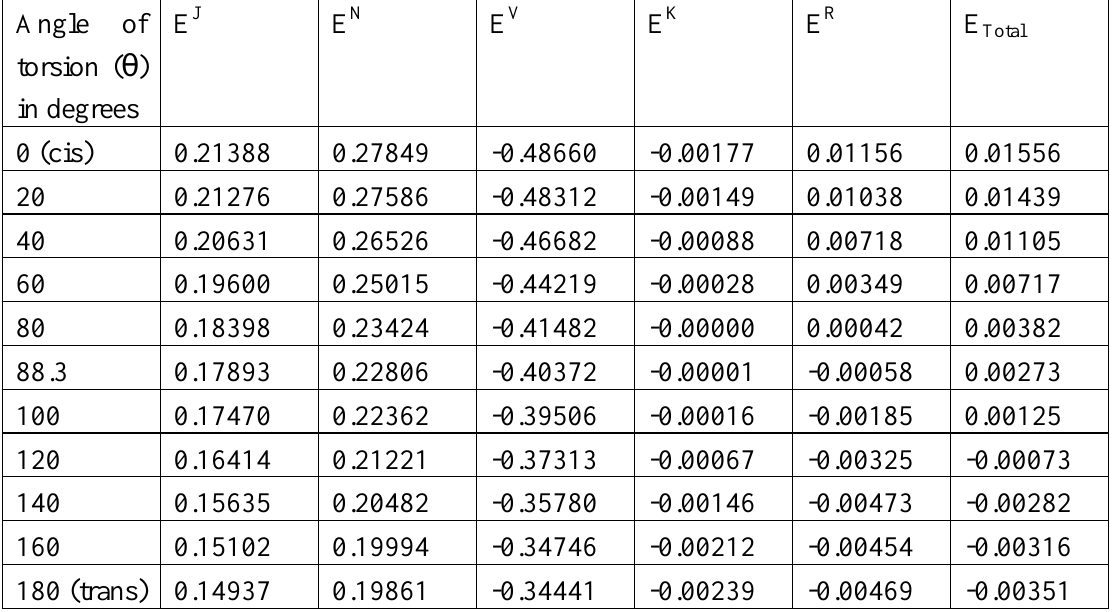
Table 5. The ‘H….H ‘ non-bonding interaction (a.u) in Hydrogen Peroxide with torsion. Angle